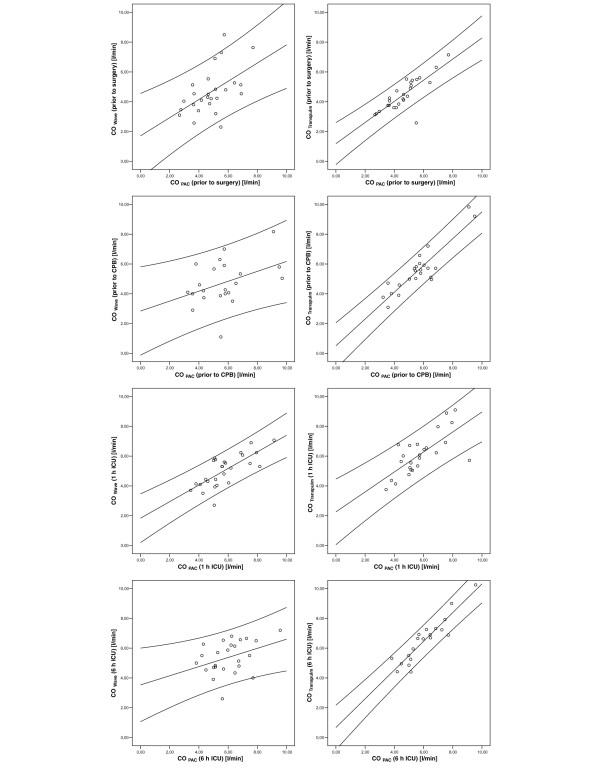
Regression analysis and Bland-Altman plots of COPAC versus COWave and of COPAC versus COTranspulm for each individual point of measurement. COPAC, pulmonary artery catheter thermodilution cardiac output; COTranspulm, aortic transpulmonary thermodilution cardiac output; COWave, uncalibrated pulse contour cardiac output; CPB, cardiopulmonary bypass; 1 h ICU, one hour after admission to the intensive care unit; 6 h ICU, six hours after admission to the intensive care unit.